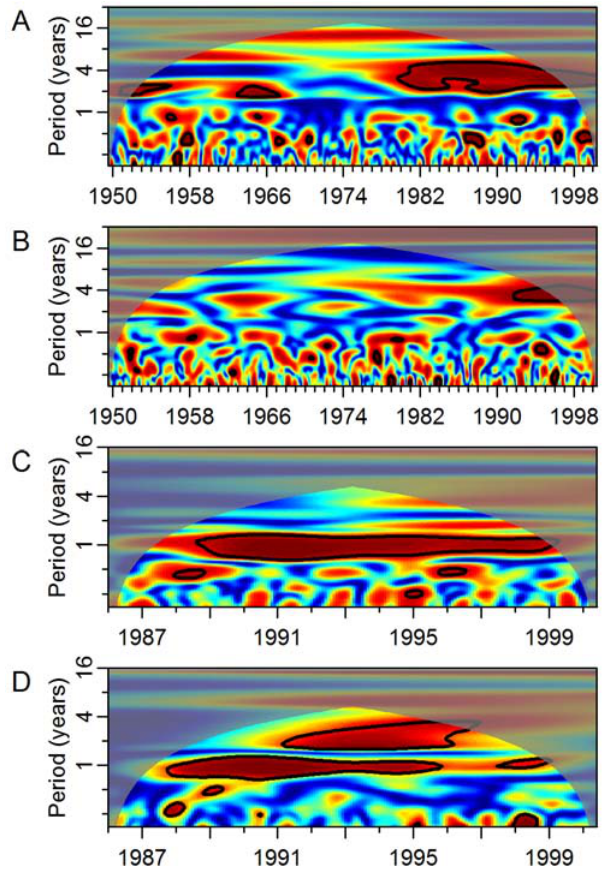
Figure 4. Coherence between ENSO, weather, and dengue in Puerto Rico. (A) Squared coherence plot of ENSO and temperature. (B) Squared coherence plot of ENSO and precipitation. (C) Squared coherence plot of temperature and dengue incidence. (D) Squared coherence plot of precipitation and dengue incidence. Features are as described in Figure